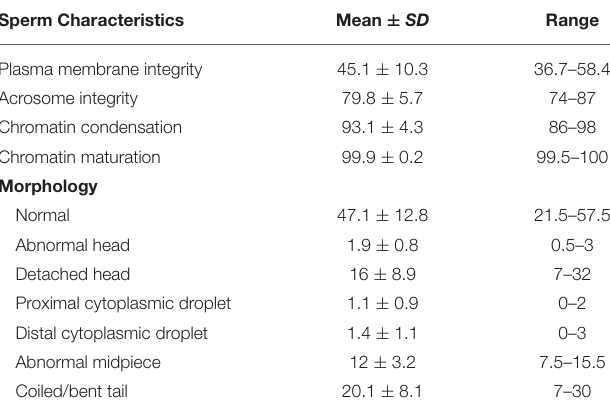
TABLE 3 | Sperm characteristics across all ejaculate